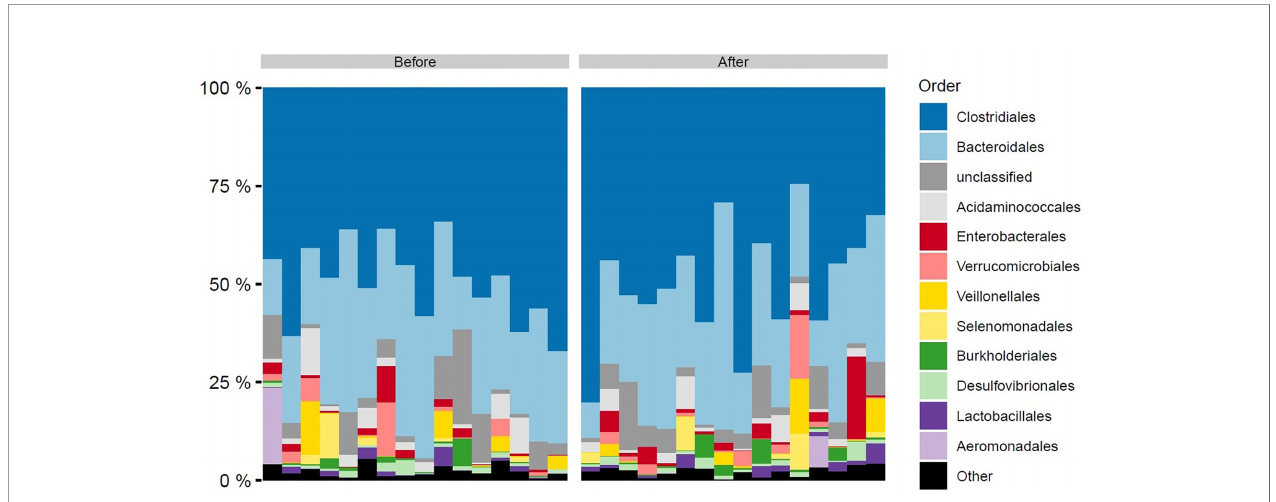
FIGURE 1 | Order level taxonomic composition of faecal samples by time of sampling before and after DMR. Each bar represents a single patient sample. DMR, duodenal mucosal